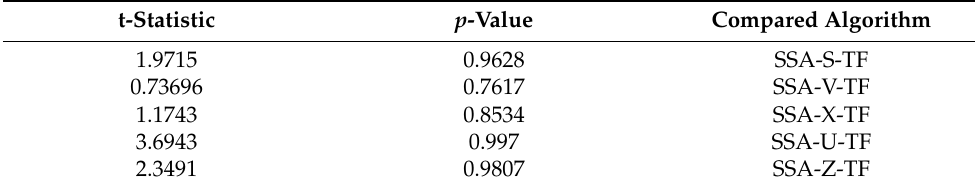
Table 3. The results of statistical testing of the t -test type based on the time processing metric of the SSA-new V-TF algorithm as the best optimization algorithm with the SSA-S-TF, SSA-V-TF, SSA-X-TF, SSA-U-TF and SSA-Z-TF